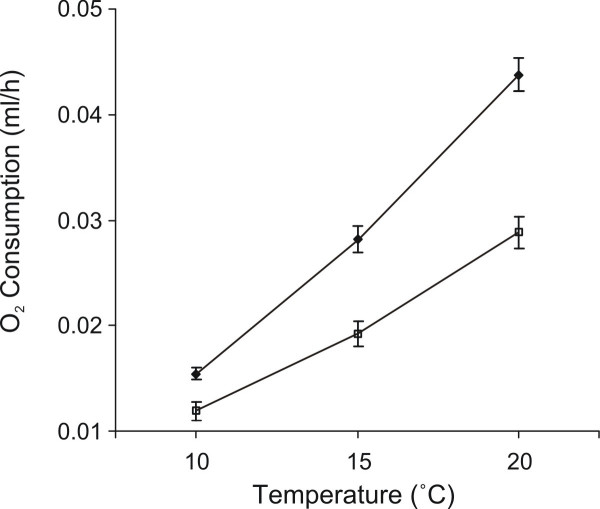
MMR Profiles by Season. MMR profiles depicting O2 consumption rates across temperatures for salamanders in the autumn and summer. Least-Square Means (adjusted for body mass variation between groups) for whole body O2  consumption rates. Closed diamonds and open squares represent autumn and summer values respectively. Error bars represent ± 1 SE.